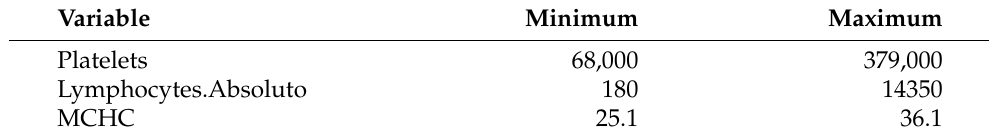
Figure 19. Heatmap of the variables per neuron level 2 TESSOM . Table 12. Minima and maxima of the variables found from neuron 2, level 2 TESSOM